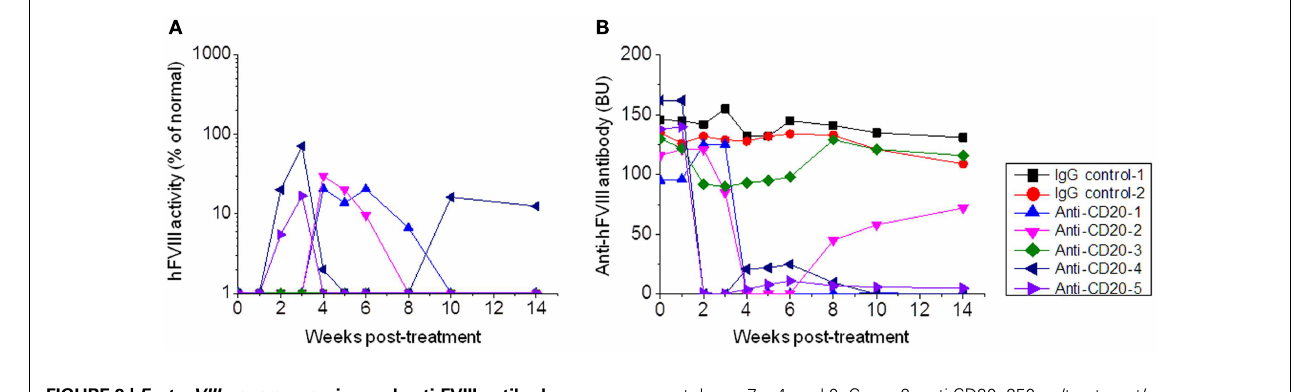
FIGURE 2 | FactorVIII gene expression and anti-FVIII antibody titers following anti-CD20 treatment in FVIII plasmid-primed hemophiliaA mice with pre-existing inhibitors . Mice were primed with FVIII plasmid to induce high-titer inhibitory antibodies at 8weeks before anti-CD20 treatment.The inhibitor mice were then treated with anti-CD20. Group 1: control rat IgG, 250 µ g/treatment/mouse, injected